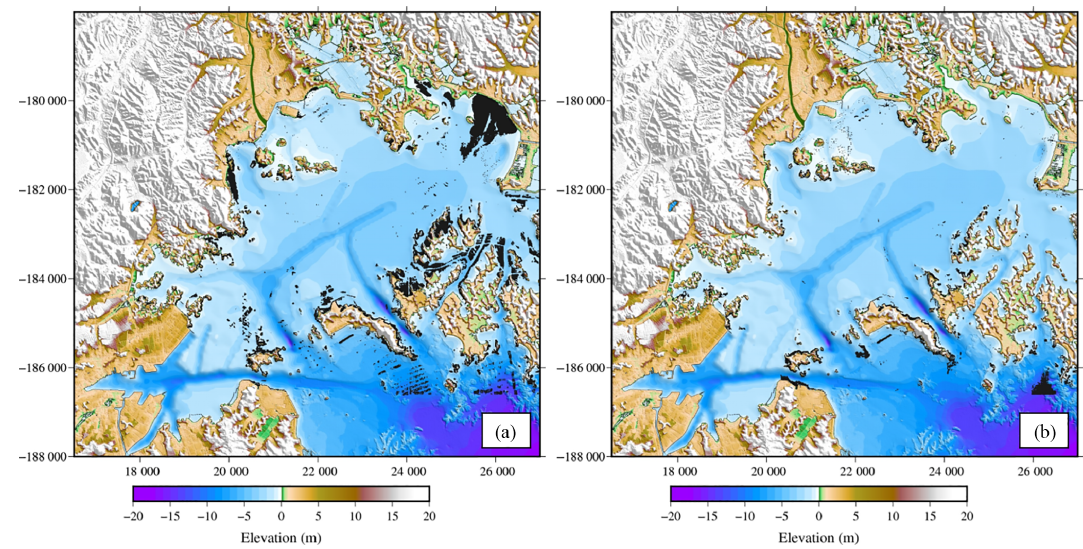
Figure 10. Areas of the eelgrass (a) before and (b) after the 2011 tsunami in Matsushima Bay.